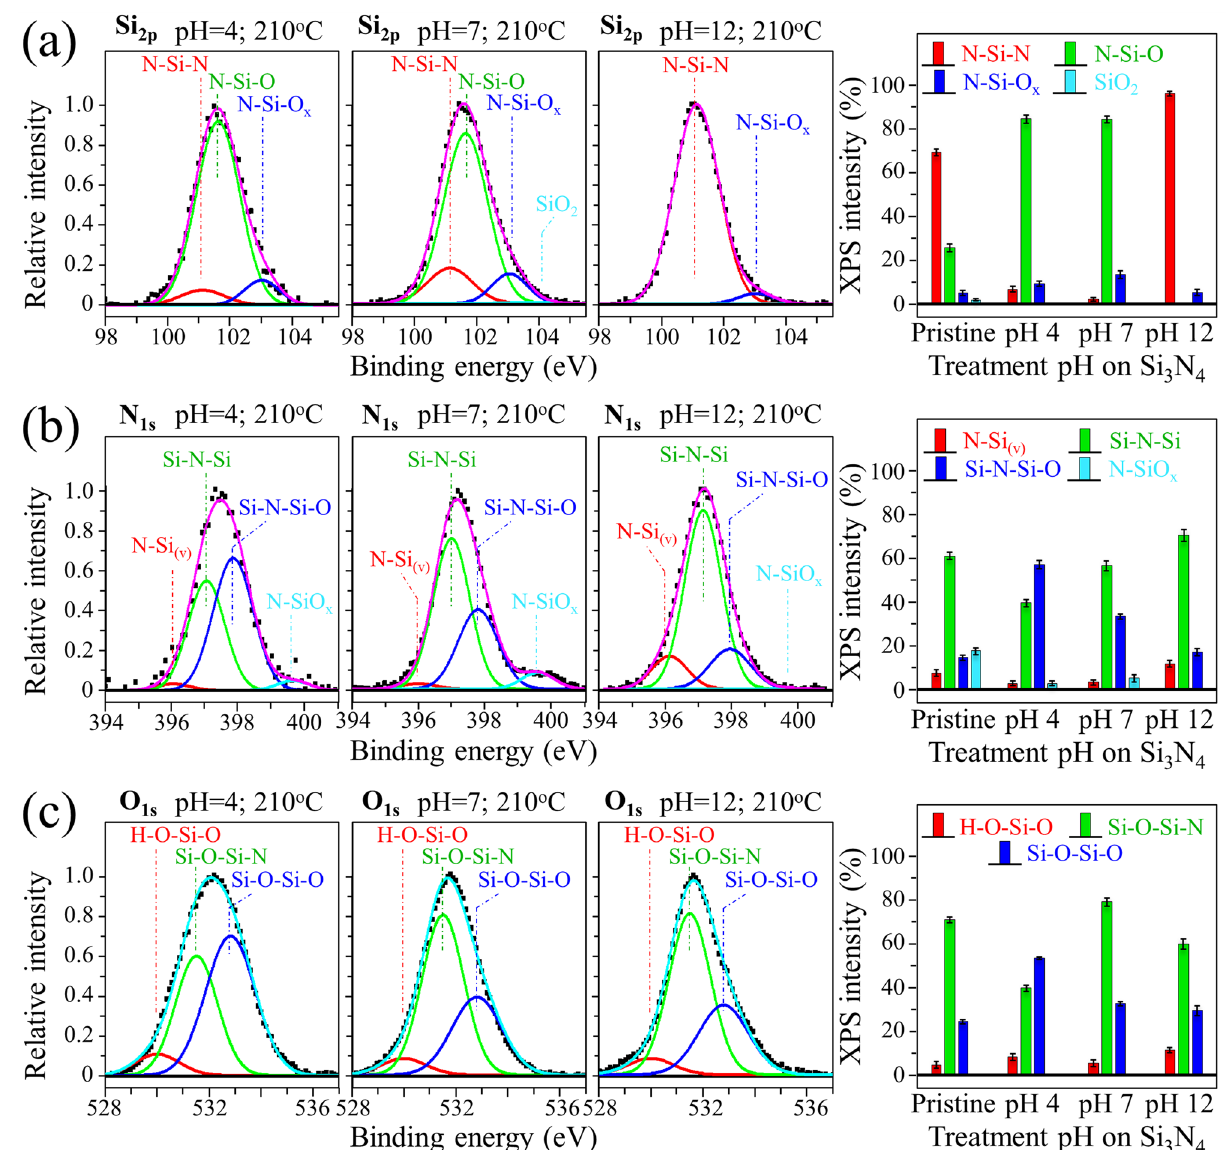
Figure 2. Deconvoluted XPS spectra of Si 3 N 4 after 48 h autoclave treatment at 210 °C in aqueous environment with pH values of 4, 7, and 12 (cf. labels in inset); narrow scans of Si 2p , N 1s , and O 1s edges are given in ( a )–( c ), respectively. The fractions of different surface bond populations (cf. labels in inset) are given in graphs on the right side of each We counted the number of plaques in cell samples and assessed virus quantities as plaque forming units PFU/100 μL as a function of virus inactivation time. Figure 4a, b show the results (with their related statistical validation) of these experiments ( n = 3) plotted in logarithmic scale for inoculation experiments conducted at room temperature and 4 °C, respectively. Comparisons are made with control cell samples inoculated with virions unexposed to Si 3 N 4 (labeled as “control”). The respective plots of reduction rate of infectious virus are also shown in the above figures. At room temperature (Fig. 4a), the PFU counts decreased and the reduction rate increased sharply as compared to control with increasing virus inactivation times. Remarkably, the reduction rate already reached ~ 90% ( p > 0.001 in Student’s test; n = 3) after exposing the virus for only 1 min to the Si 3 N 4 powder. For exposure times equal to or longer than 10 min reduction rates > 99.8% were recorded for all cell samples inoculated with Si